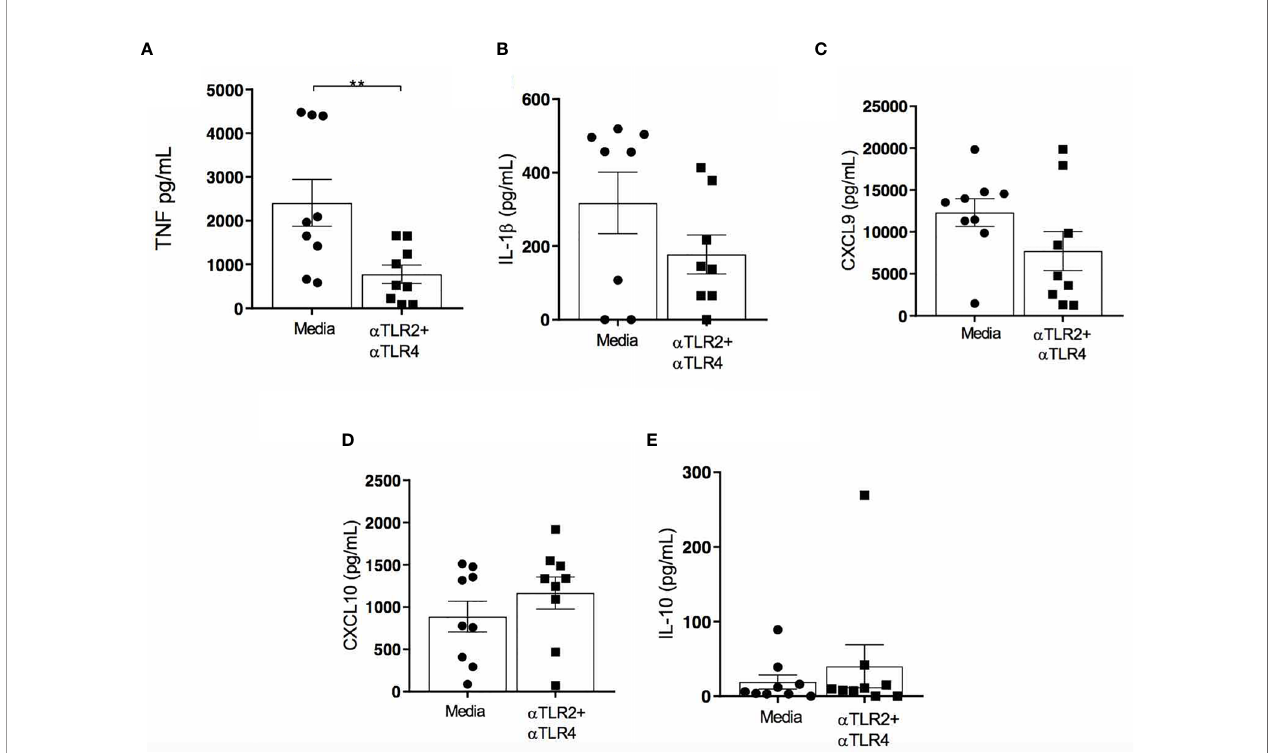
FIGURE 7 | Effects of TLR2 and TLR4 neutralization on cytokine/chemokine production in biopsied cells from CL patient lesions. Cells from the lesions of patients with CL (n=10) were obtained and cultured for 48h in the presence or absence of anti-TLR2 and anti-TLR4. TNF (A) , IL-1 b (B) , CXCL9 (C) CXCL10 (D) and IL-10 (E) were measured in culture supernatants by ELISA. Data are representative of median cytokine/chemokine levels. All p values were obtained using Wilcoxon signed-rank test;